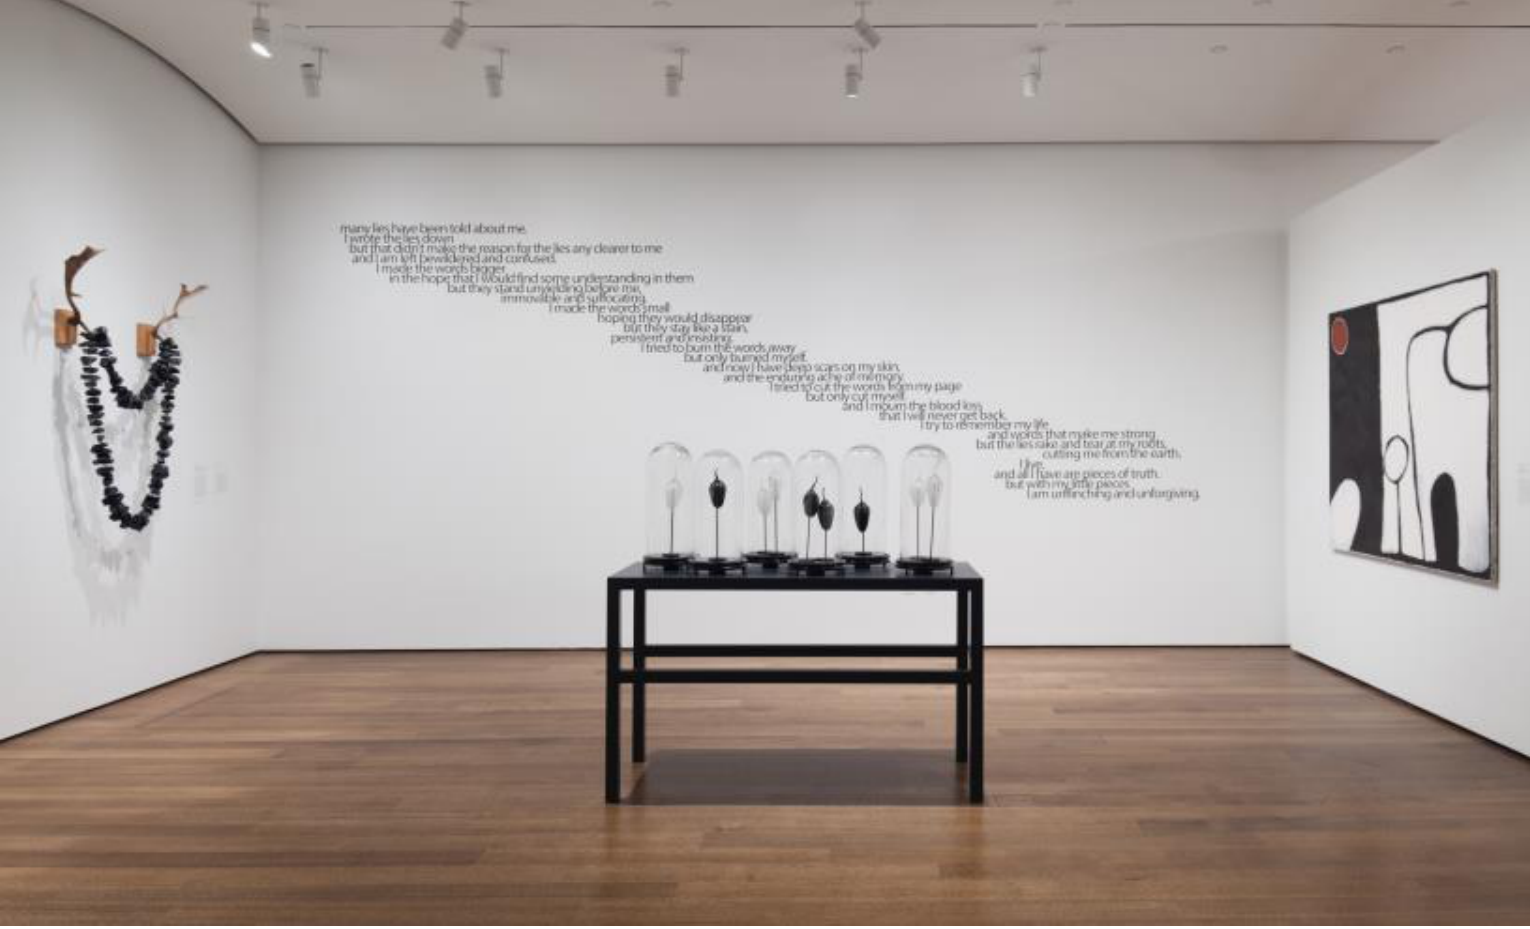
Contemporaneity: Historical Presence in Visual Culture http://contemporaneity.pitt.edu Vol 5, No 1 “Agency in Motion” (2016 ) | ISSN 2155-1162 (online) | DOI 10.5195/cont.2016.183